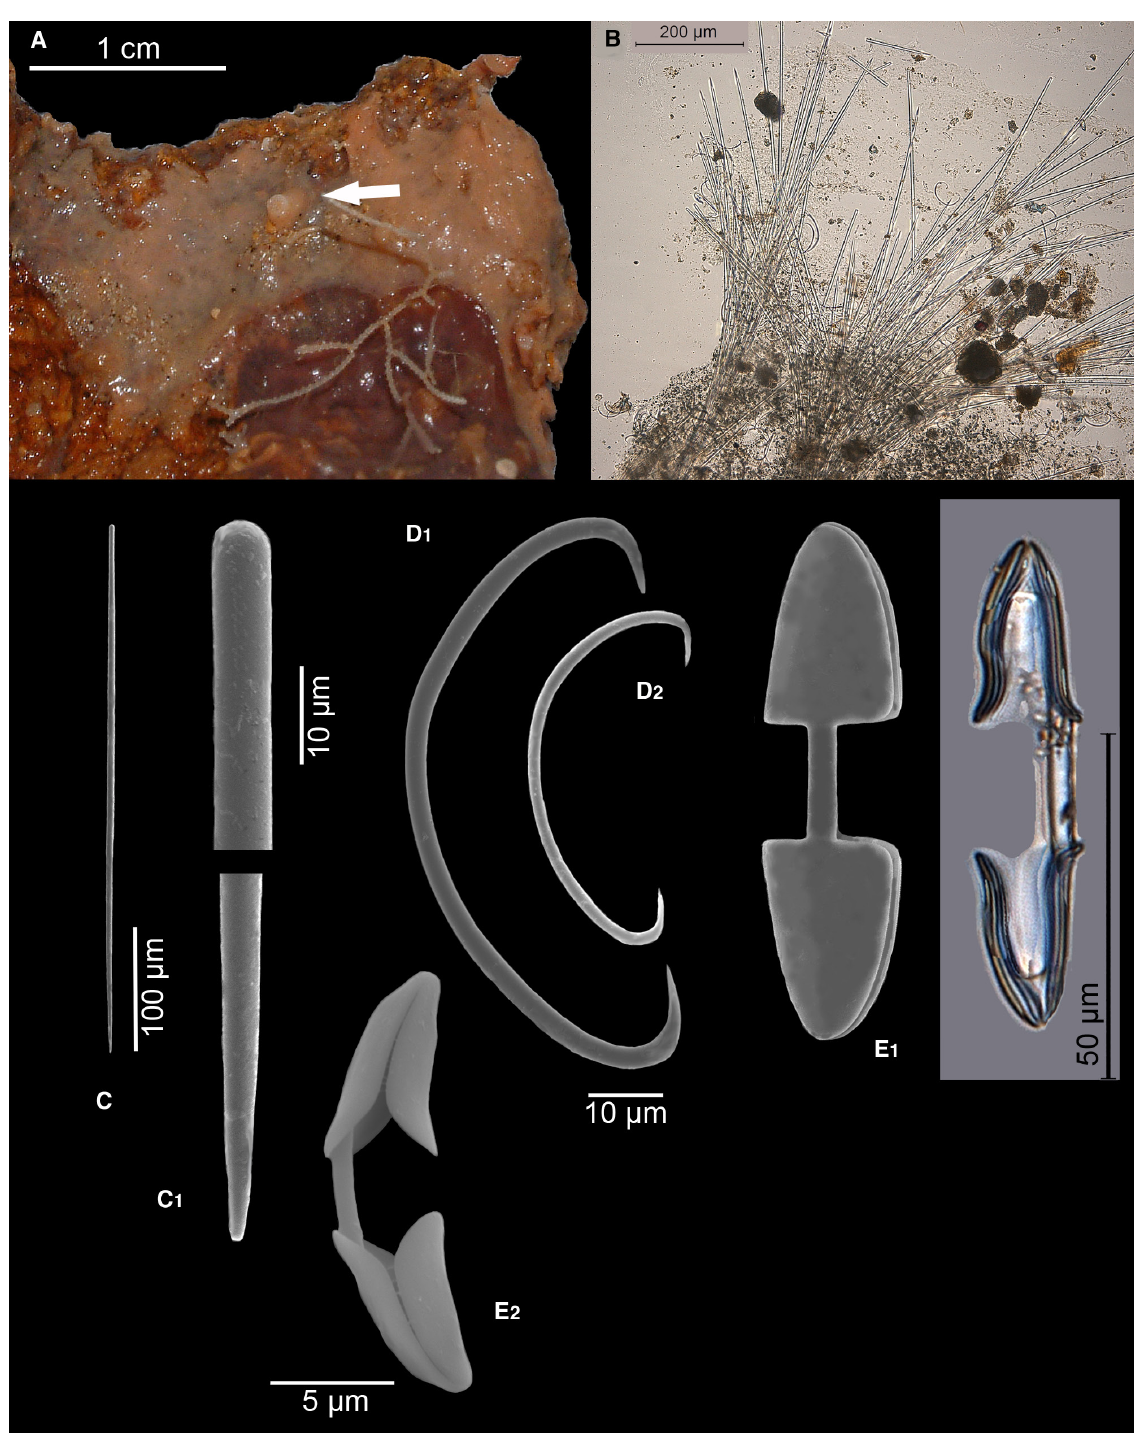
Fig. 6. Esperiopsis cimensis sp. nov., Holotype ZMA Por. 07282. A . Habit encrusting a volcanic rock (indicated by arrow). B . Cross section of peripheral skeleton showing plumose spicule brushes. C-E . SEM and light microscopy images of spicules. D . Style. D Small sigma. E . Palmate isochelae. E E . Small 2